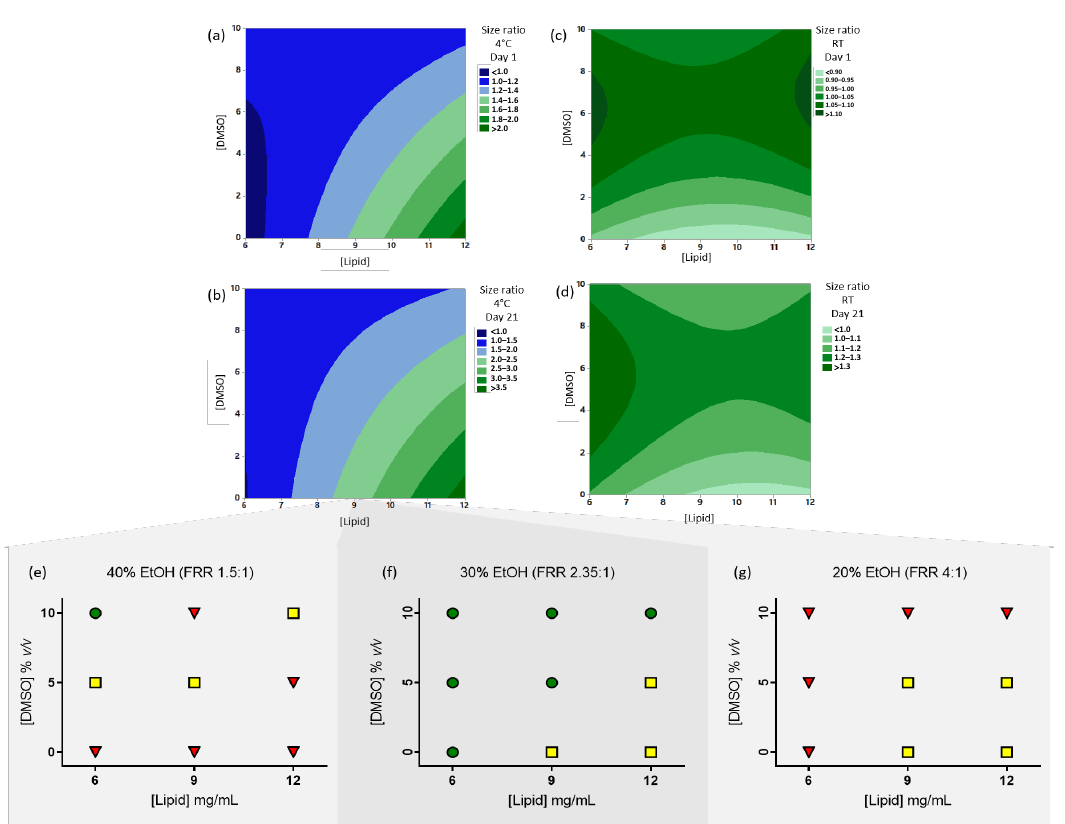
Figure 2. The data from design of experiments were analyzed using face-centered response surface methodology to evaluate the e ff ects of the parameters [Lipid] and [DMSO] at a fixed [EtOH] of 30% v / v . Contour plots for the size ratios at ( a ) day 1, storage at 4 ◦ C, lack-of-fit p = 0.320, adj. r 2 = 63.68%, ( b ) day 21, storage at 4 ◦ C, lack-of-fit p = 0.145, adj. r 2 = 72.73%, ( c ) day 1, storage at room temperature (RT), lack-of-fit p = 0.179, adj r 2 = 20.88% and ( d ) day 21, storage at room temperature (RT), lack-of-fit p = 0.081, adj. r 2 = 18.93%. Particle stability of samples stored at 4 ◦ C for 21 days was evaluated qualitatively. Samples prepared at ( e ) 20% EtOH (FRR 4:1), ( f ) 30% EtOH (FRR 2.35:1) and ( g )